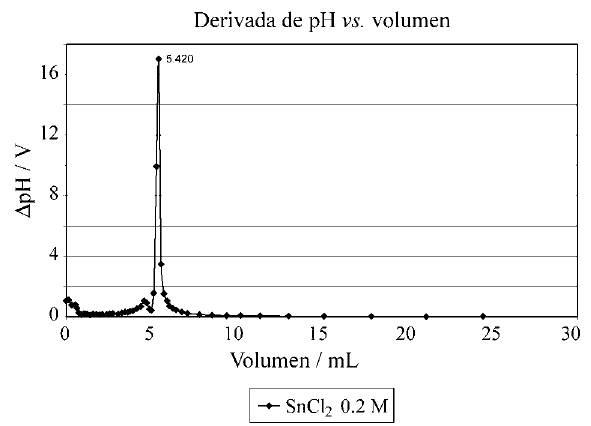
Figura 1b. Primera derivada de la curva potenciométrica para un diso- lición 0.2 M de SnCl 2 .